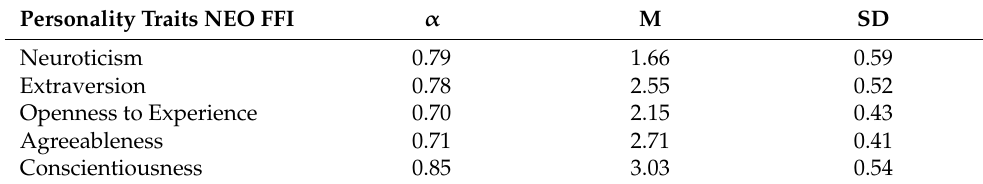
Table 3. Results of the methodology of personality traits NEO FFI: α , M, SD. Personality Traits NEO FFI